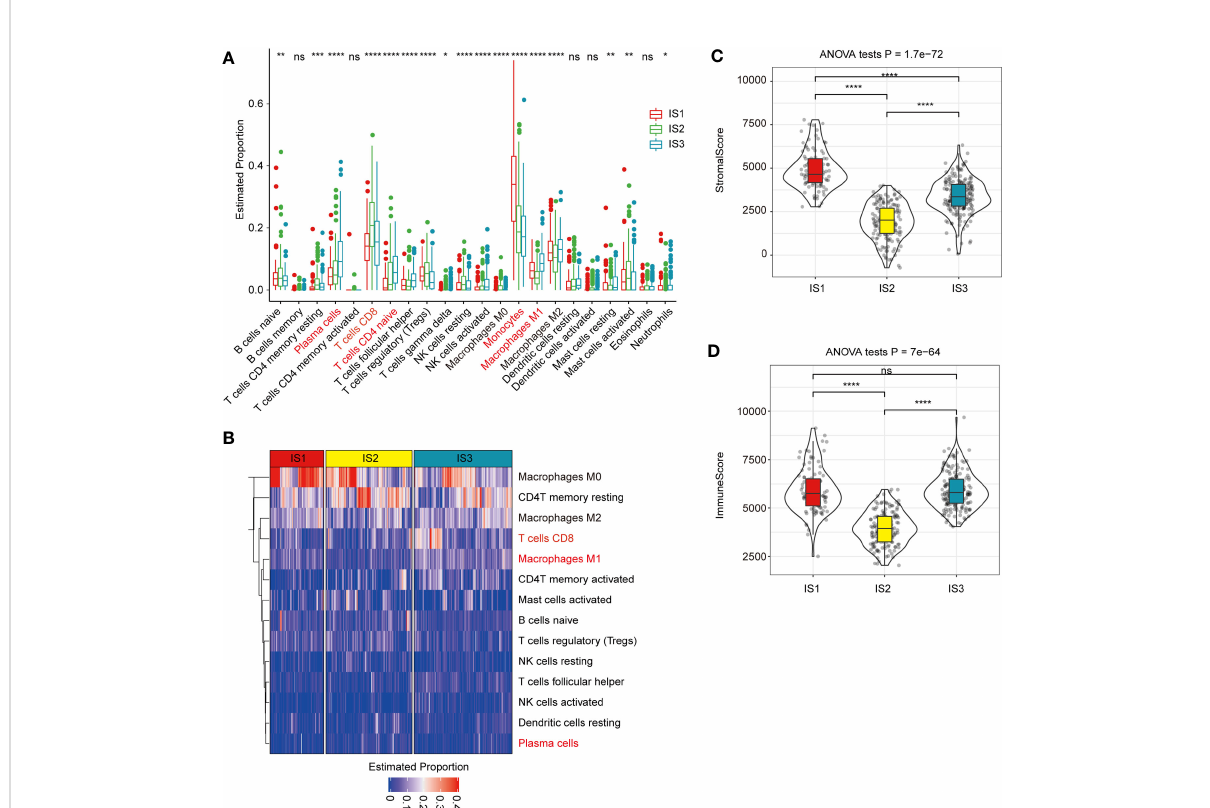
FIGURE 4 Association between immune subtypes and COAD-related tumor biomarkers in TCGA-COAD dataset (A) . The estimated proportion of immune cell in fi ltration among immune subtypes. CD8 T cell is highlighted in pink. The top and bottom of the box are the upper quartile (Q3) and the lower quartile (Q1) of the data, respectively. The solid black line in the box represents the median. The whiskers represent the maximum and minimum values of this group of data. The Kruskal – Wallis test was used to assess for signi fi cant differences. ns, not signi fi cant, * P < 0.01, ** P < 0.001, *** P < 0.0001, and **** P < 0.00001. (B) Heat map for the estimated proportions of immune cells in the samples among immune subtypes. CD8+ T cell is highlighted in pink and signi fi cantly higher in IS3 subtypes. (C, D) . The proportions of StromalScore (C) or ImmuneScore (D) among immune subtypes in TCGA -COAD cohorts. IS1 has the highest relative proportion of stromal cells in TME, while IS2 has the lowest relative proportion of immune cells. We used the Kruskal – Wallis test and Wilcoxon test to compare the signi fi cance among the three groups and pairwise comparison between groups, respectively. The solid black line in the box represents the median, and the inner black box in the violin plot represents the quartile range. The black vertical line running through the violin chart represents the interval from the minimum value to the maximum value, respectively. ns, not signi fi cant, * P < 0.01, ** P < 0.001, *** P < 0.0001, and **** P <